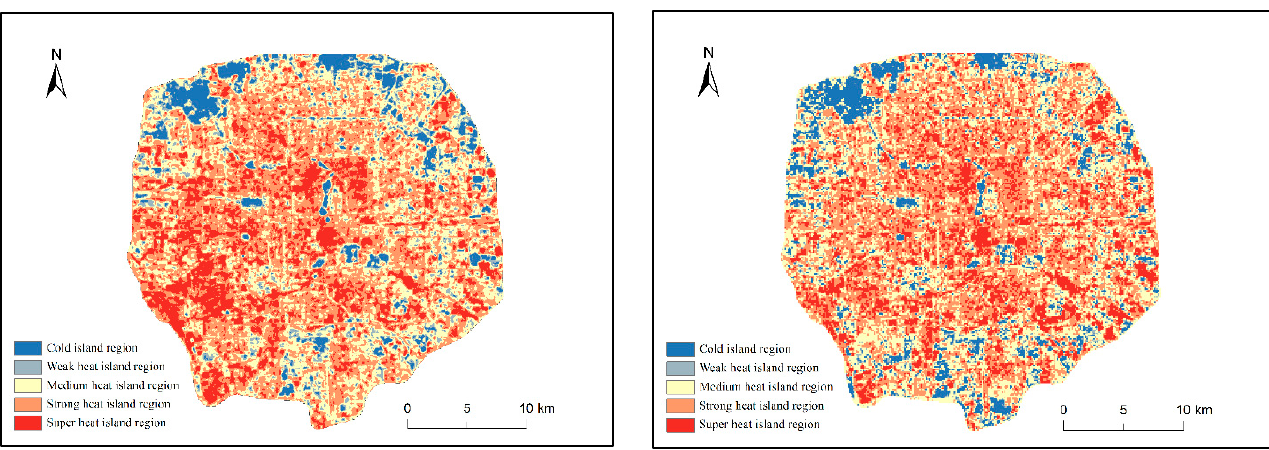
Figure 7. Distribution diagram of SUHI grade.